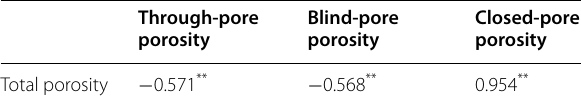
Table 2 Results of Pearson’s correlation